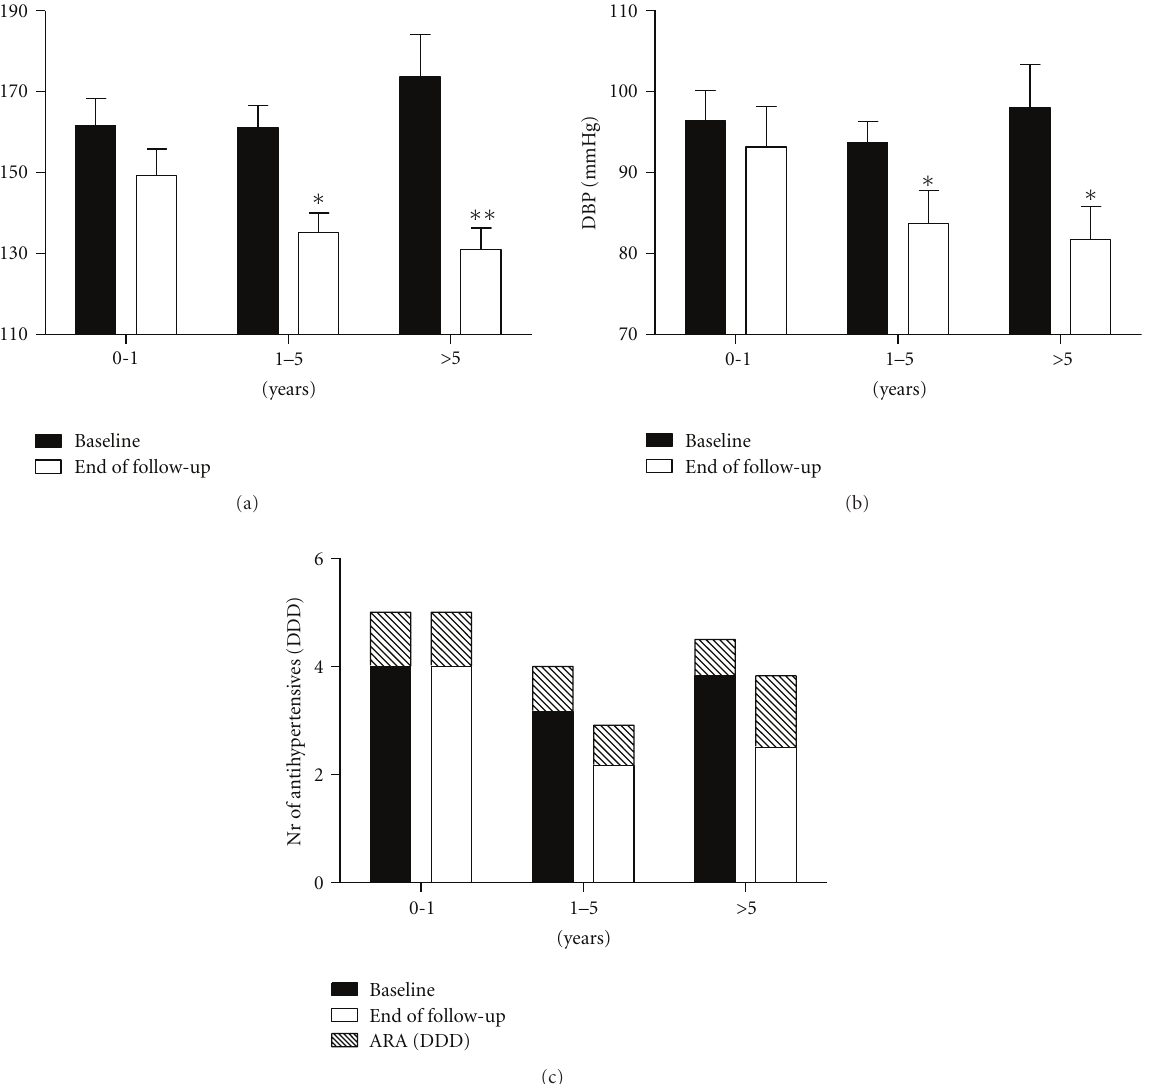
Figure 4: Systolic (SBP) (a), diastolic (DBP) (b) blood pressure and medication use (defined daily dose, DDD) (c) at baseline and end of followup after stratification for followup duration for patients with essential hypertension (Figure 3) and primary aldosteronism (Figure 4). Indicated in (c) is the DDD for the aldosterone-receptor antagonist (ARA). For baseline, this is added up to total DDD; at the end of followup, this is part of the total DDD since ARA was started at baseline. Di ff erences were tested with paired t -test for SBP and DBP and Wilcoxon Signed Ranks test for DDD (DDD without ARA at baseline versus DDD including ARA at the end of followup).